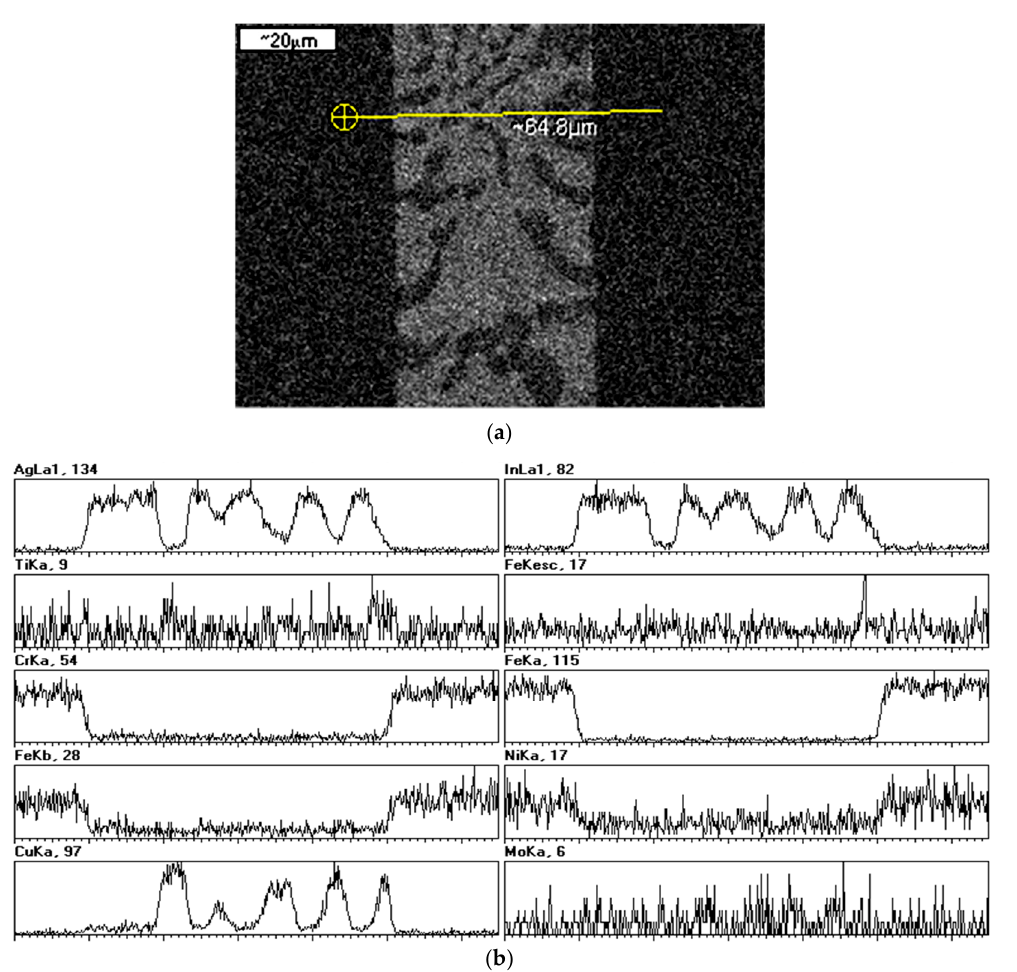
Figure 3. ( a ) SEM micrograph and ( b ) EDS line scans of a cross section of a 316L stainless steel/Cu ‐ Ag ‐ In ‐ Ti brazed joint.